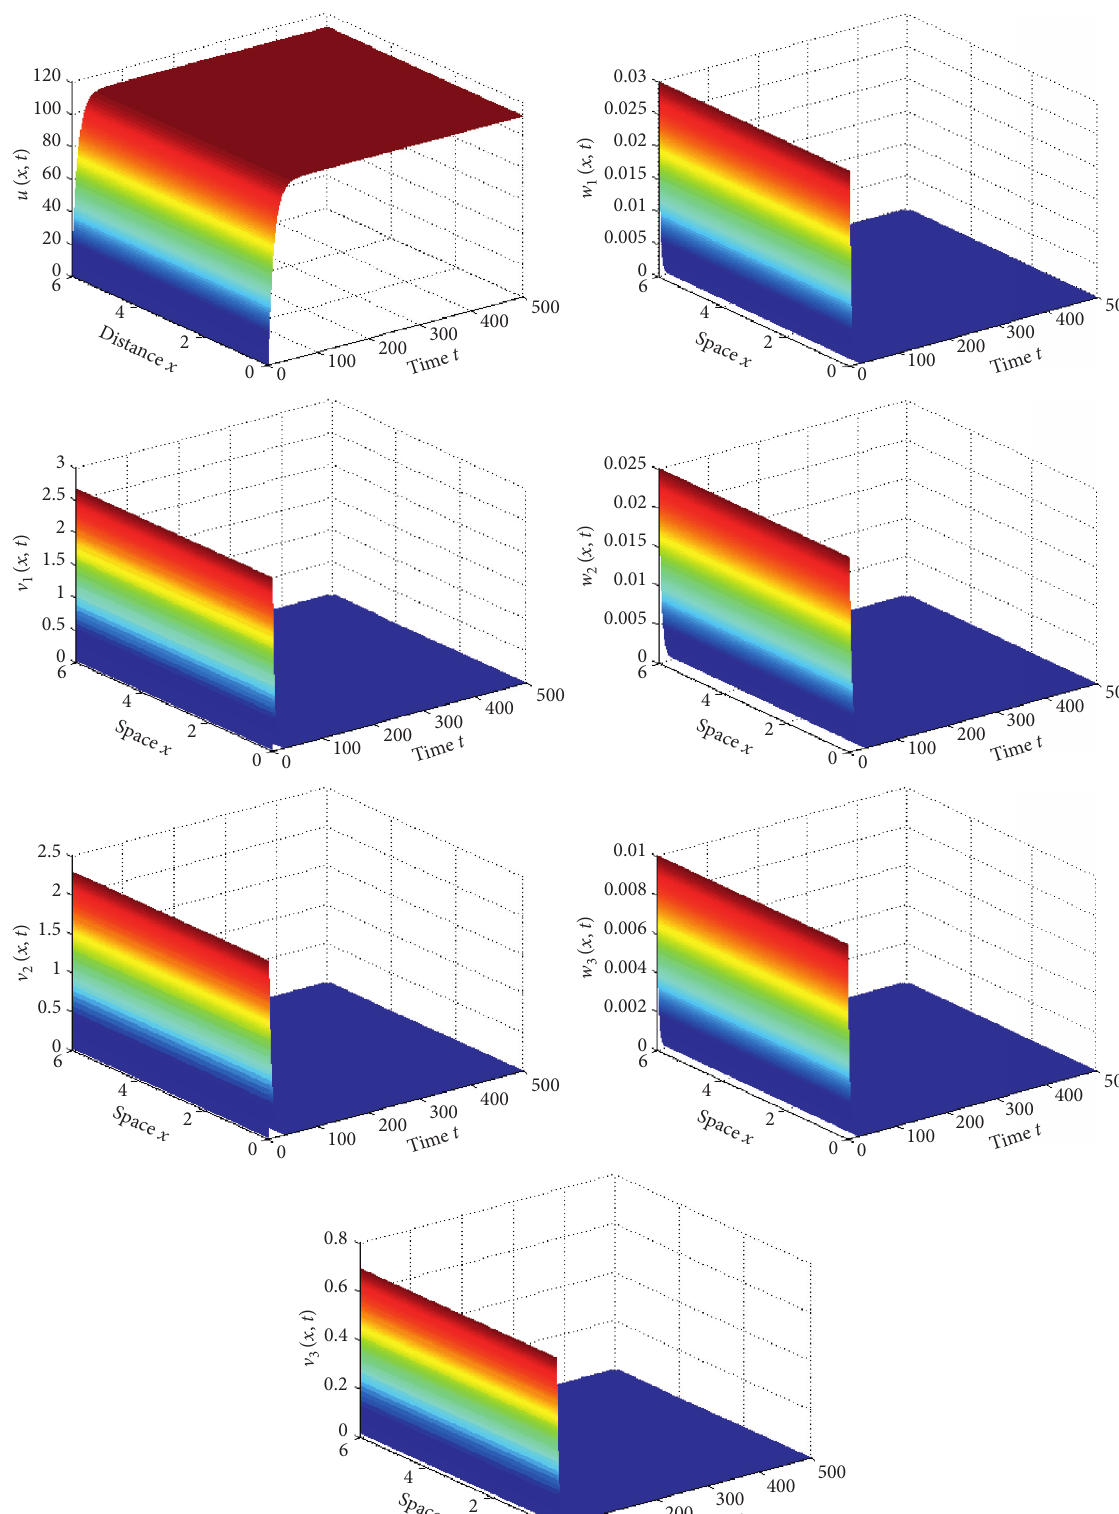
Figure 5: Taking m � 0 . 0015, δ β 2 for strain 3, we have R model (62) is globally asymptotically